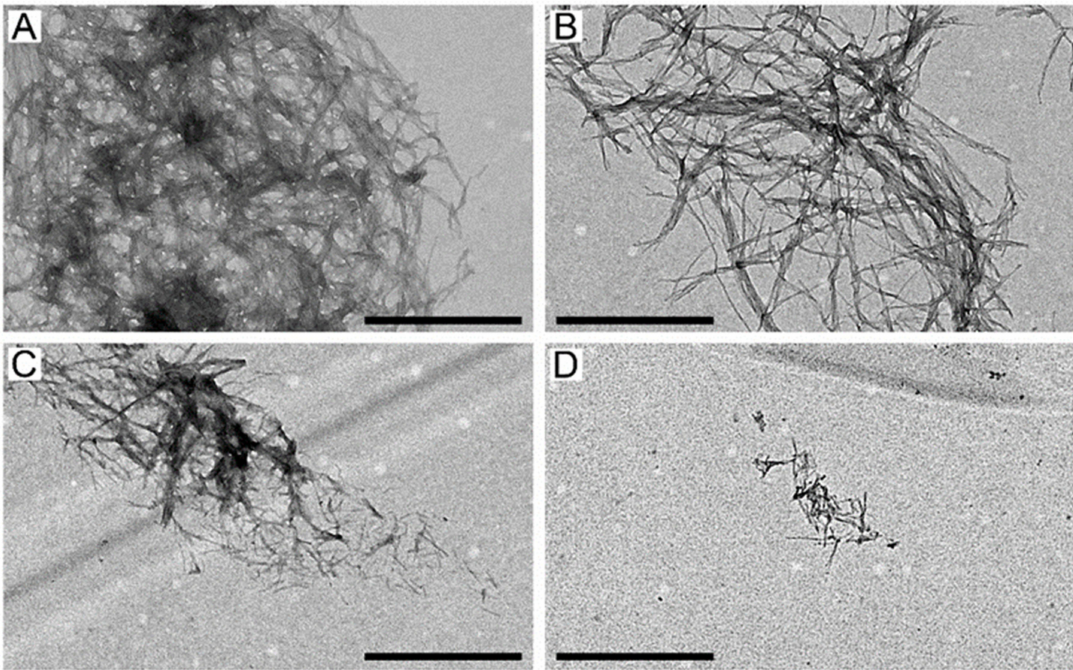
Figure 5. Negative staining TEM images of the 20 µ M A β 40 fibers grown in the course of the ThT fluorescence assay shown in Figure 3A in the absence ( A ) or in the presence of 20 µ M IBU ( B ), 2 µ M HSA ( C ), and 2 µ M HSA and 20 µ M IBU ( D ). The scale bars represent 1 µ